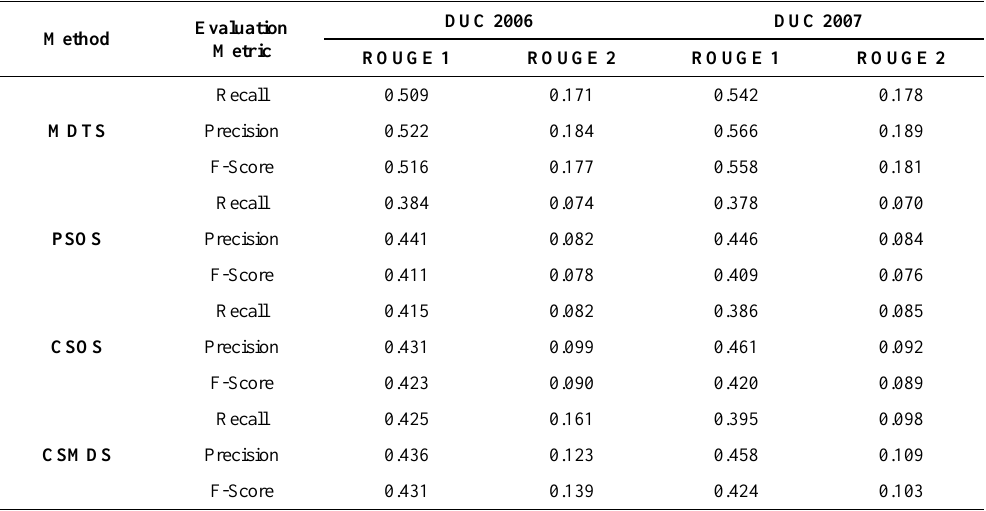
Table 1. ROUGE N Score calculation for MDTS comparing with PSOS,CSOS and MDSCSA tested on DUC 2006 and DUC 2007